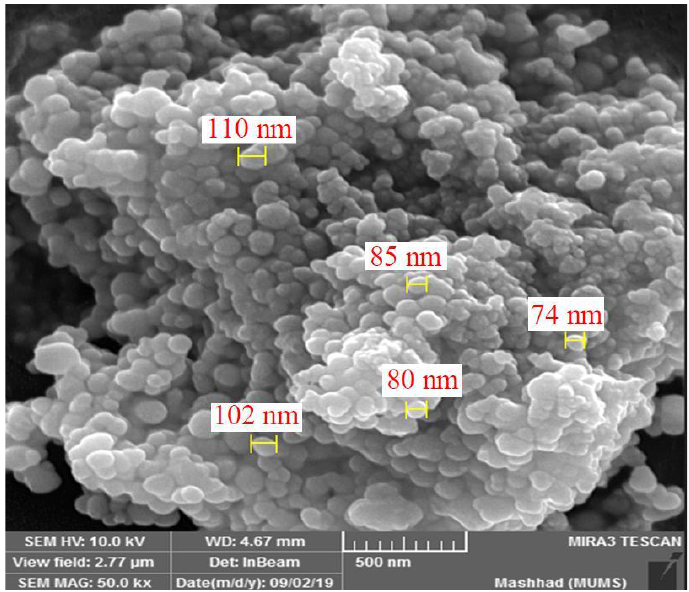
Fig. 1. SEM of H Fig. 1 . SEM of H 3 PW 12 O 40 -amino-functionalized CdFe 12 O 19 @SiO 2